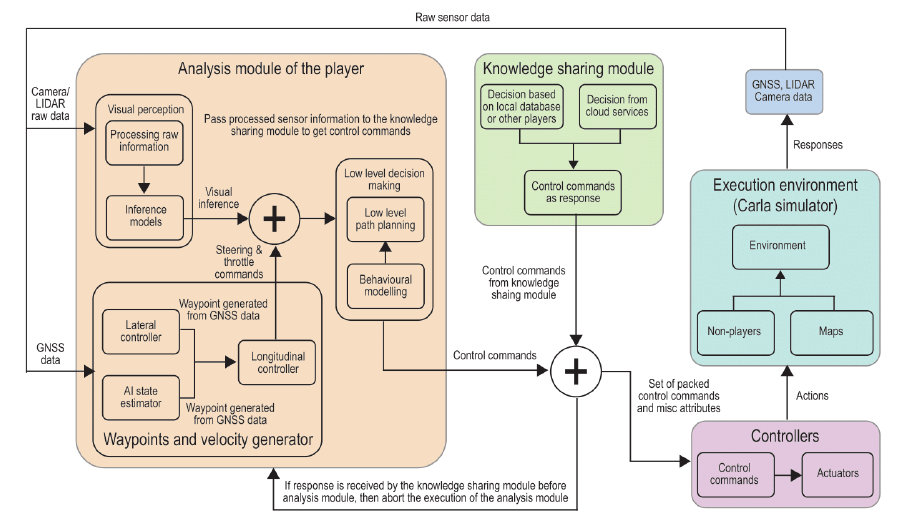
Figure 1. Architecture of the proposed TAKEN